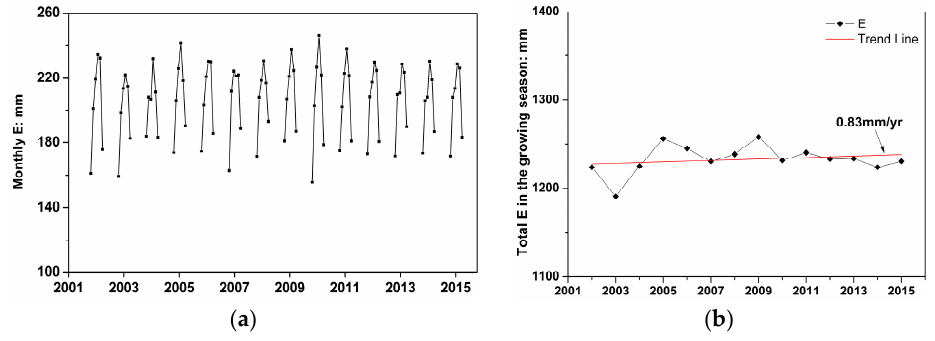
Figure 9. Estimated monthly ( a ) and growing season ( b ) lake evaporation in 2002–2015.